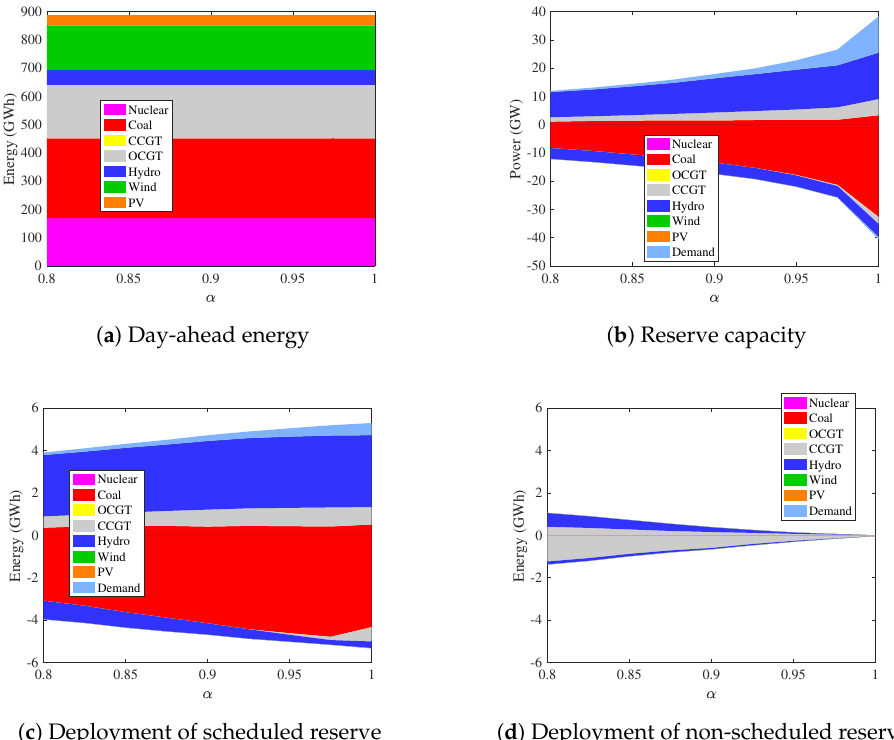
Figure 6. Scheduling and deployment of energy and reserve with respect to α